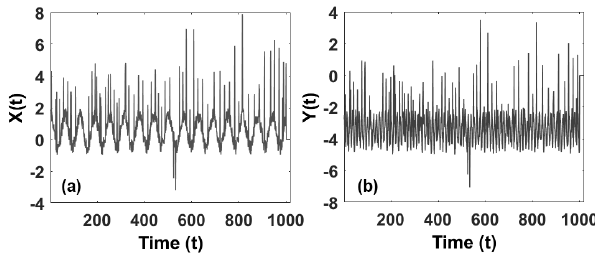
Figure 3. Test signals X(t) (a) and Y (t) (b) with two distinct fre- quencies having a lagged relationship induced by H (t) used to ex- plain the